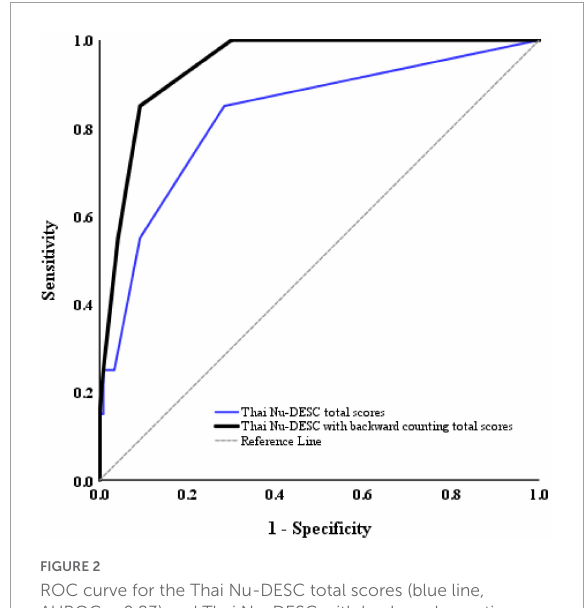
FIGURE2 ROC curve for the Thai Nu-DESC total scores (blue line, AUROC = 0.83) and Thai Nu-DESC with backward counting total scores (black line, AUROC =